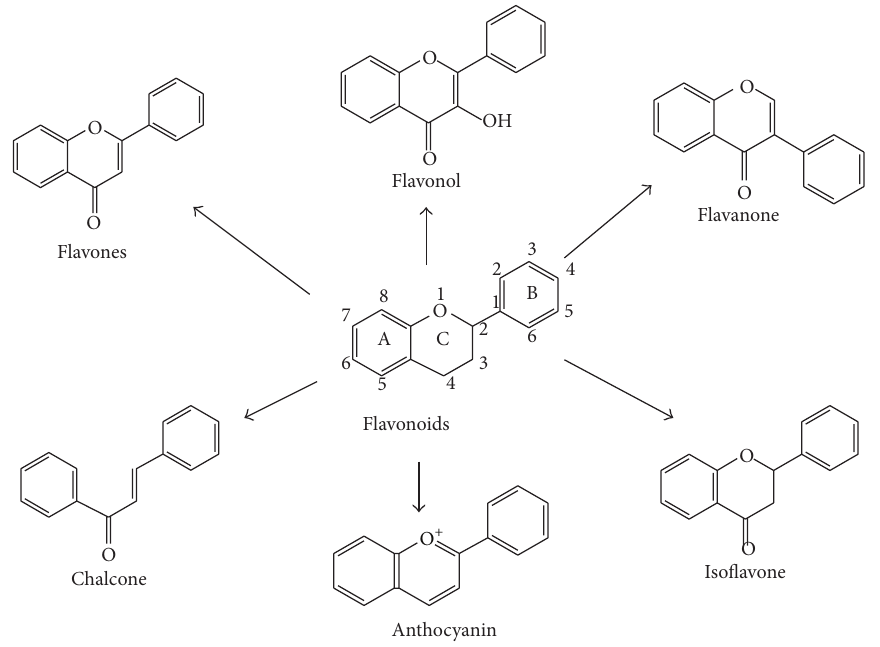
Figure 1: Basic chemical structures of different natural occurring